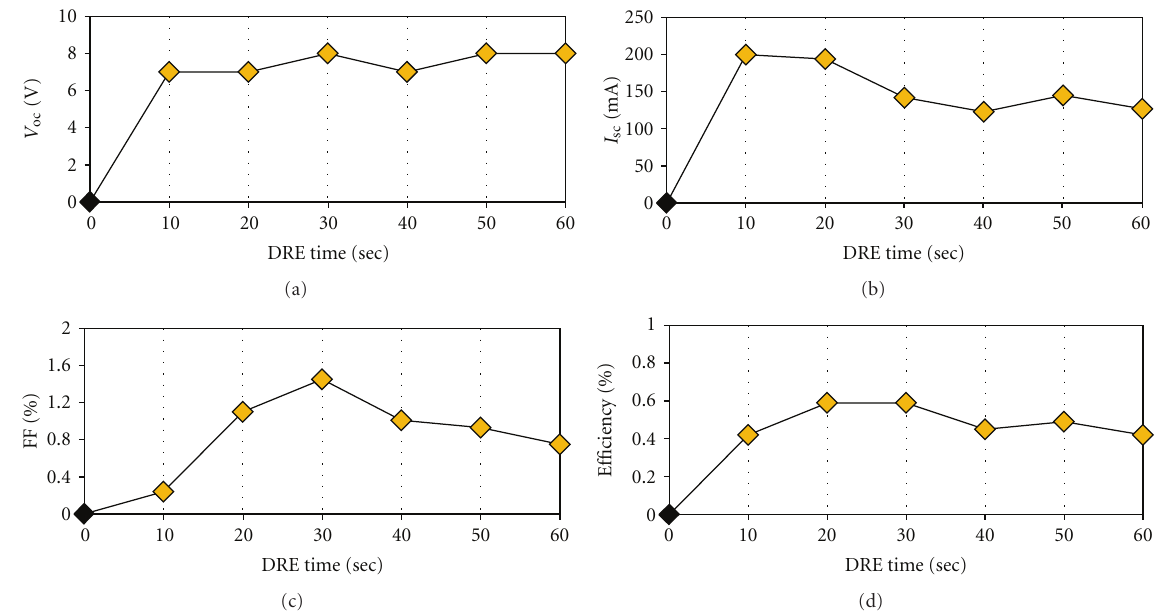
Figure 6: Electrical characteristics of RIE-textured mc-Si solar cells with various DRE times. (a) Open circuit voltage ( V oc ). (b) Short circuit current ( I sc ). (c) Fill factor (FF). (d) Conversion e ffi ciency.